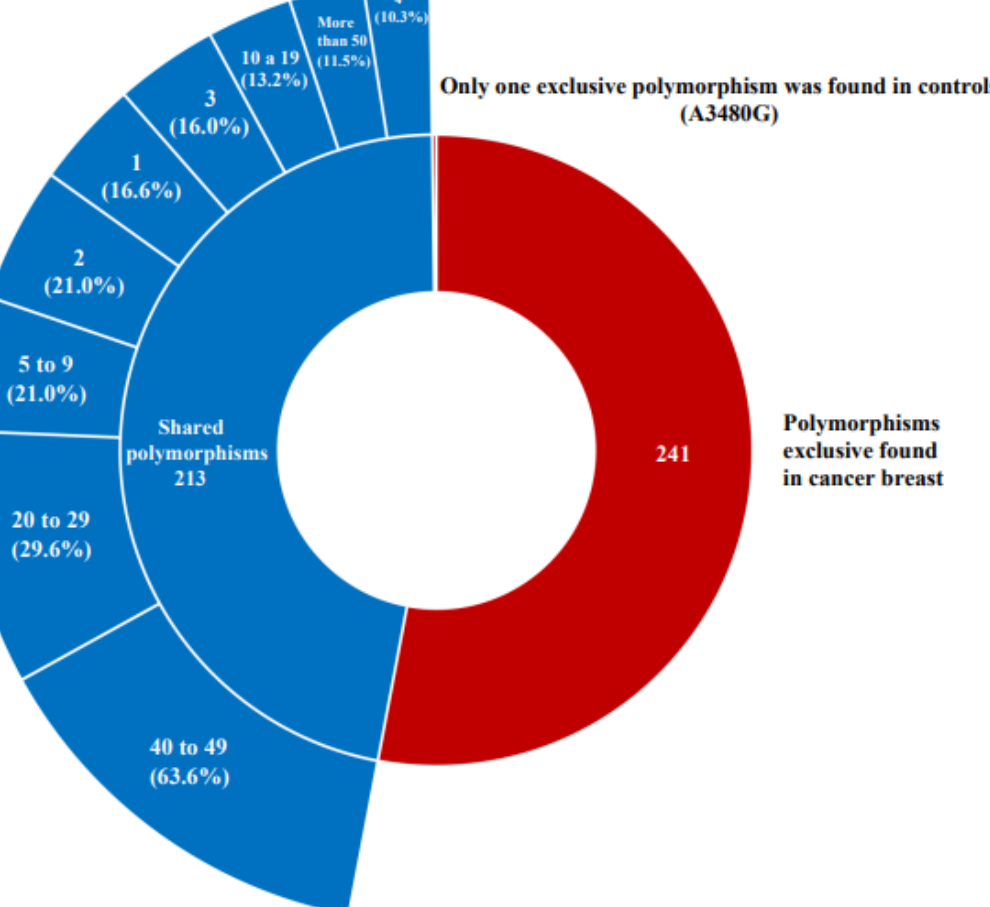
Figure 1. The frequency of the variant repetitions among the different complete sequences obtained from individuals diagnosed with breast cancer and from the control groups.